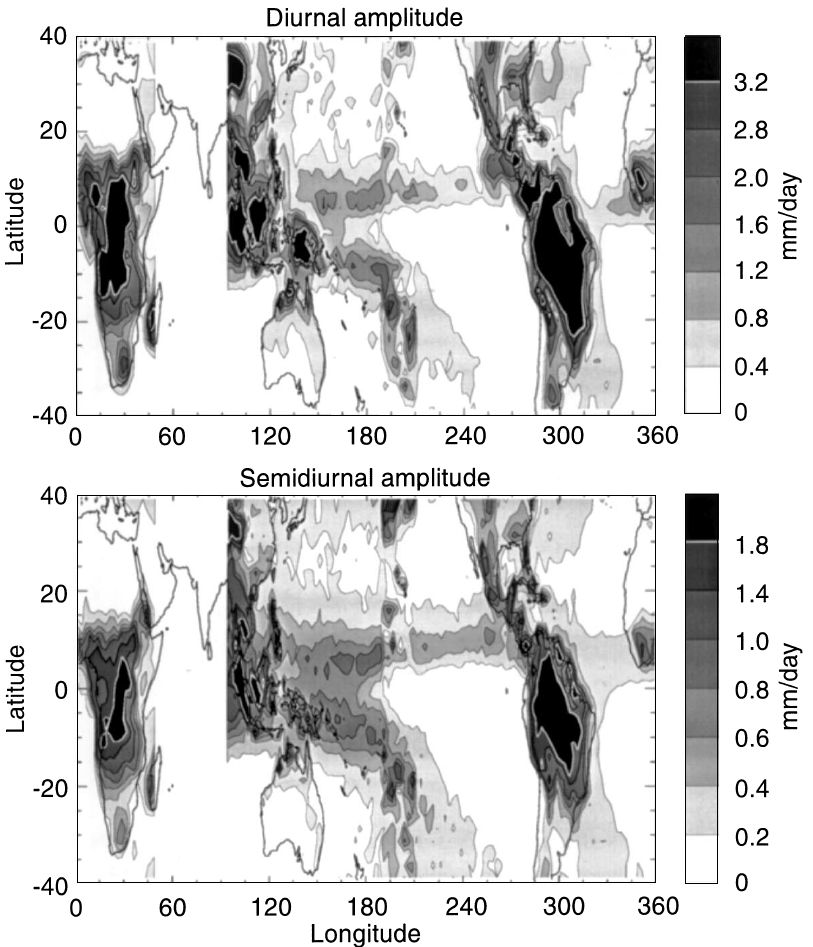
Fig. 1. Diurnal ( top ) and semidiurnal ( bottom ) harmonic components of the 7-year (1988– 1994) annual-mean rainfall-rate distribution, as derived from satellite-based cloud brightness temperature measurements. Satellite data are not available between about 50 (cid:176) E and 90 (cid:176) E (Janowiak et al